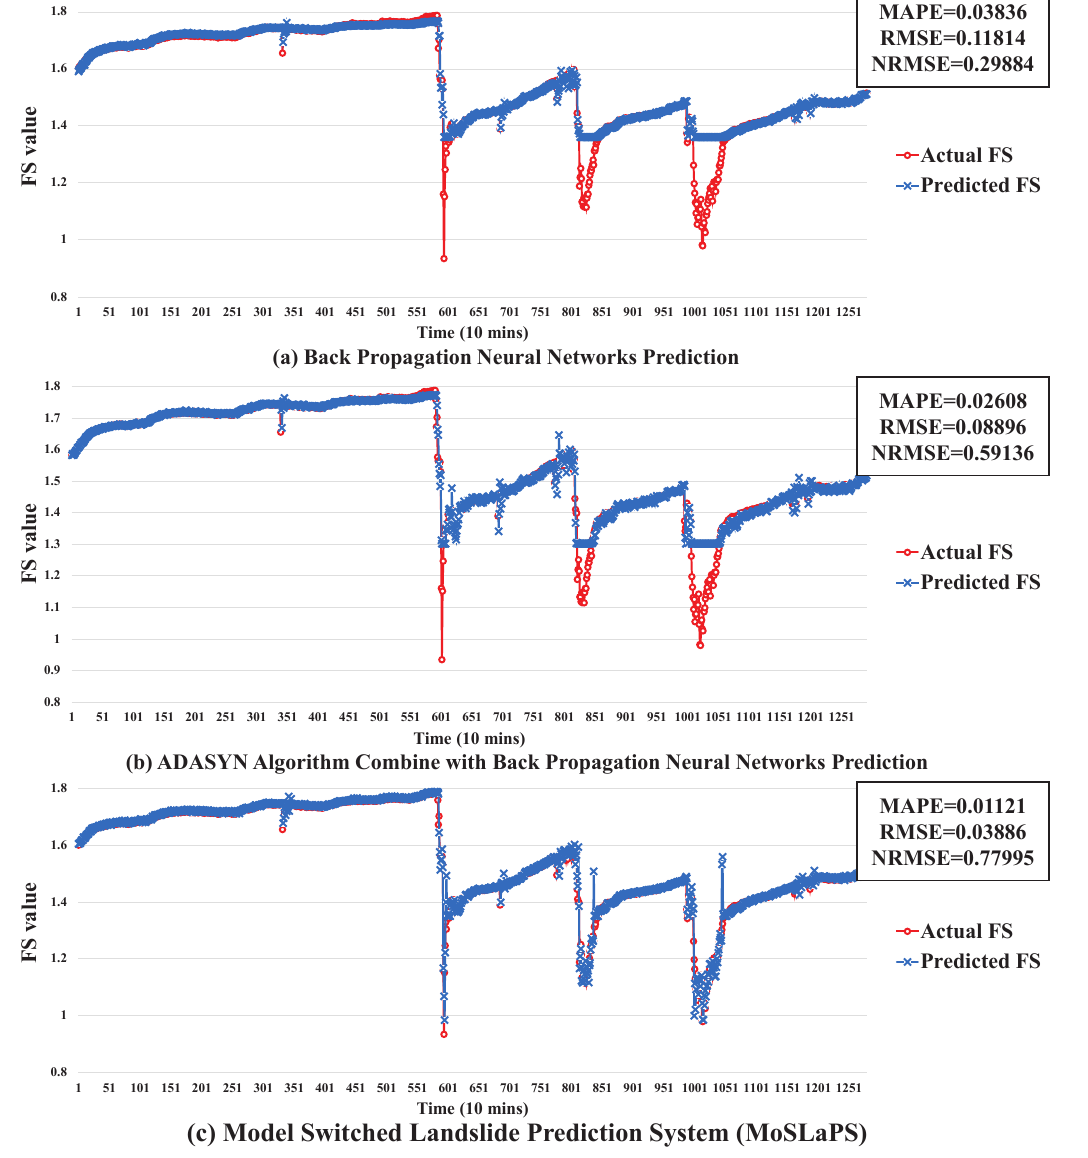
Figure 13. Comparison of the proposed method with other BPNN